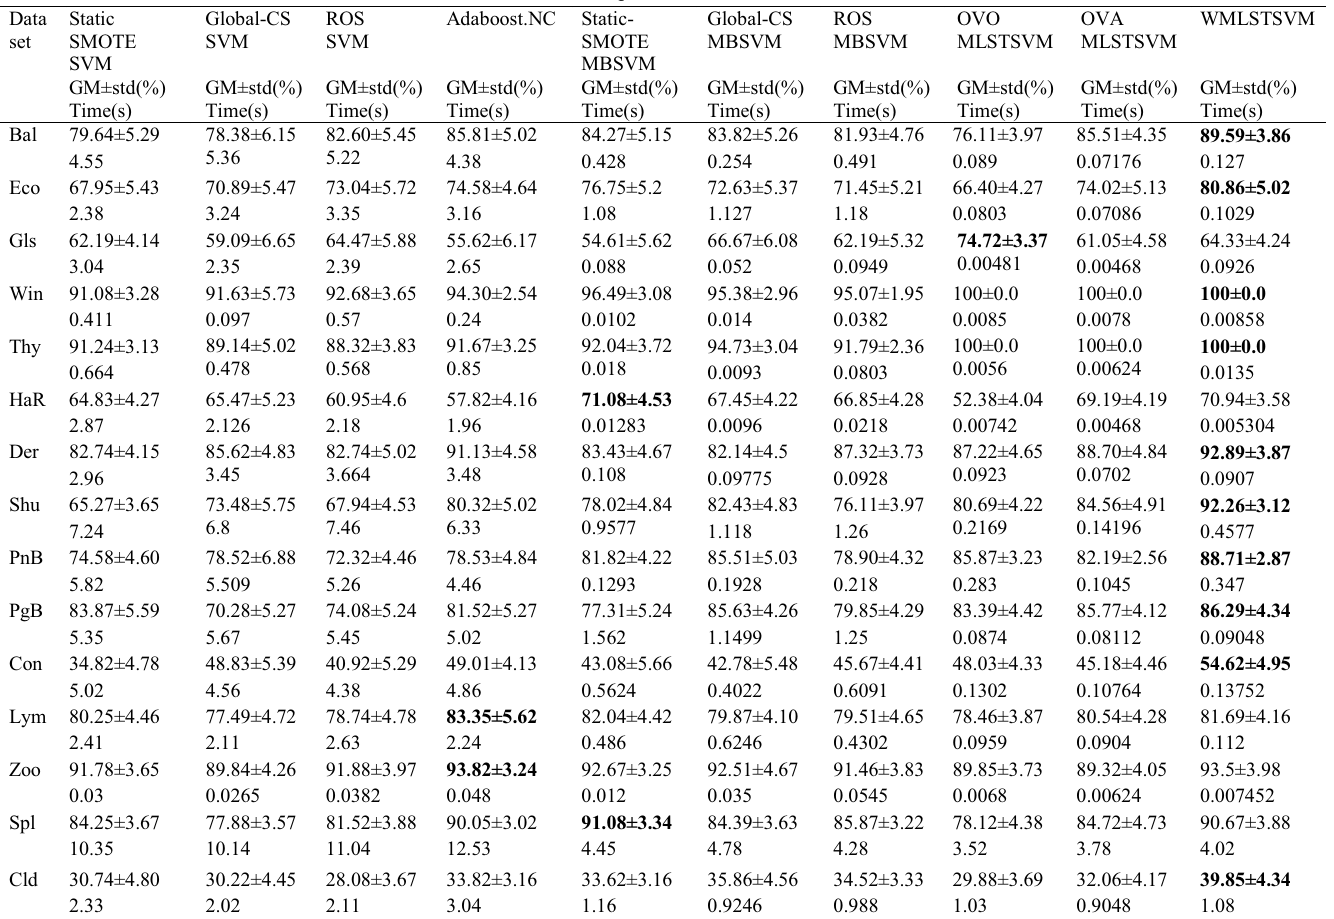
Table 3. Geometric Mean Comparison of linear classifiers on benchmark